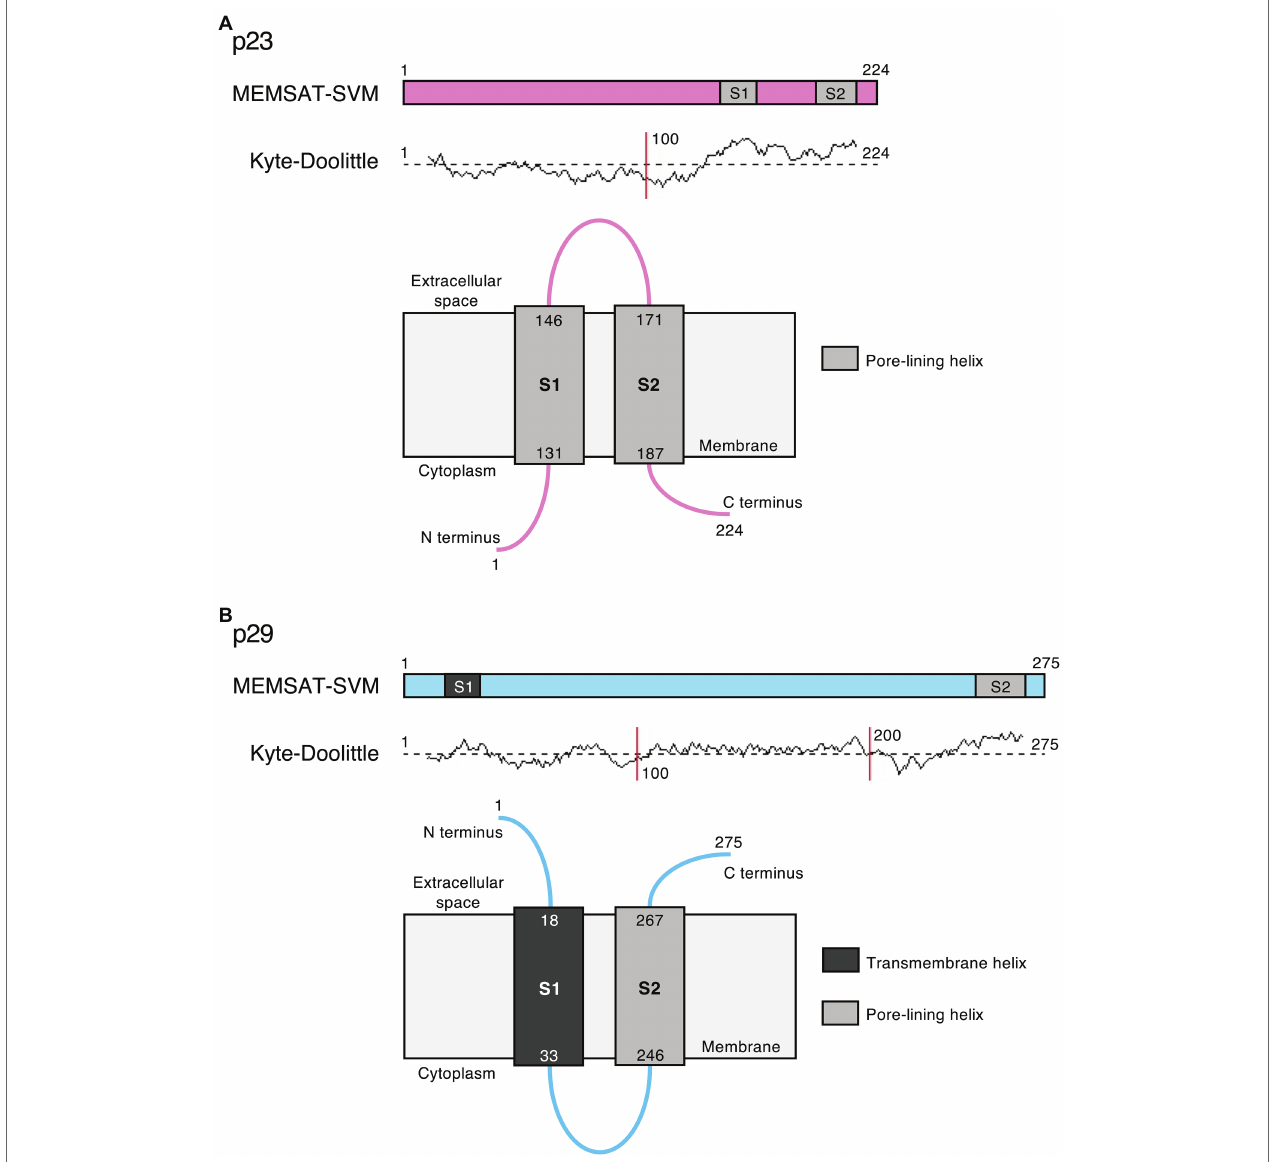
FIGURE 5 | Potential viroporin domains in the lagovirus (RHDV) non-structural proteins. Sequence analysis using PSIPRED secondary structure prediction tools (Buchan and Jones, 2019) revealed transmembrane (dark gray) and/or amphipathic pore-lining helices (light gray) in (A) p23 (pink) and (B) p29 (light blue); the MEMSAT-SVM algorithm (Nugent and Jones, 2012) was used for protein topology prediction; and Kyte-Doolittle plots indicate the hydrophobicity of amino acids. Note that the exact intracellular localization of p23 and p29 and the orientation of these proteins in cellular membrane(s) is currently unknown; if they localize to the ER, the term “cytoplasm” would indicate the lumen of the